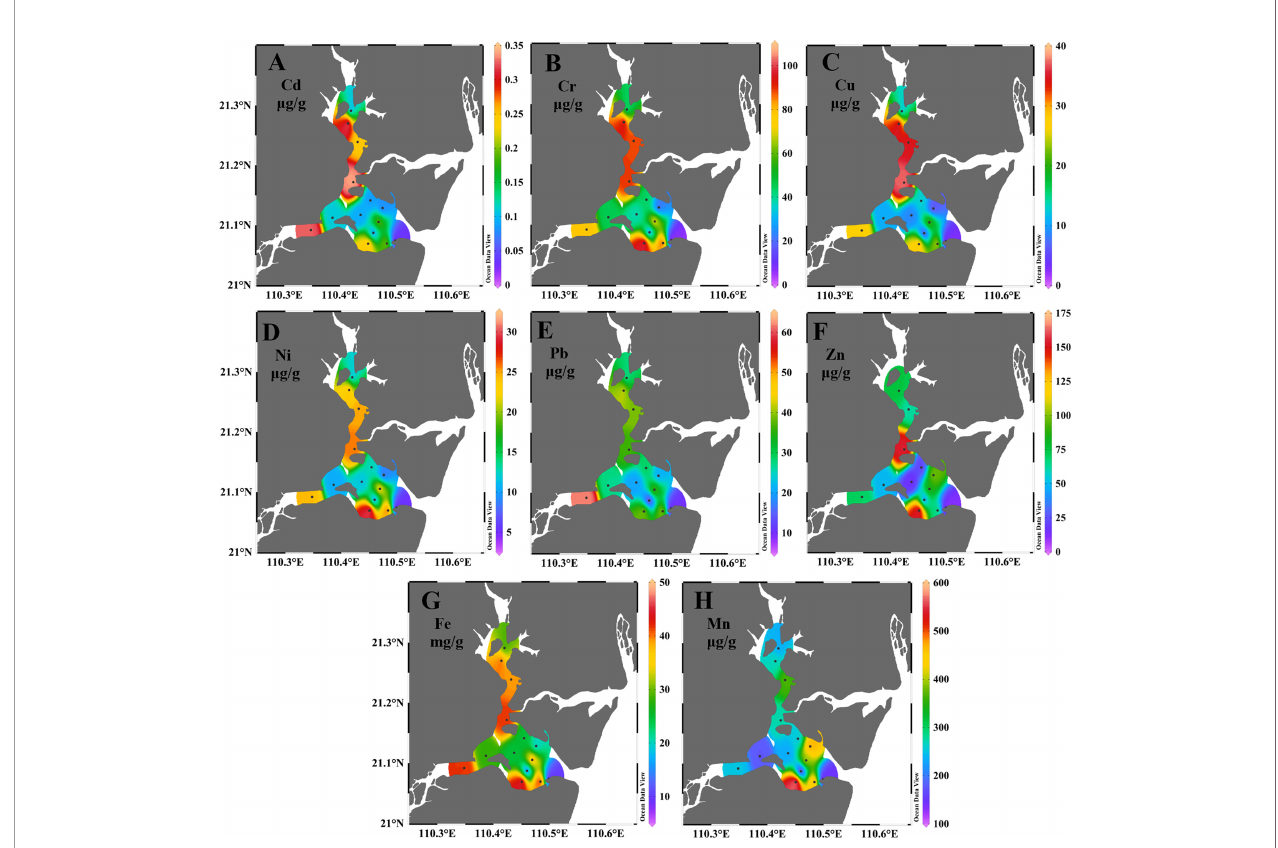
FIGURE 2 | The distribution of total metal concentrations for Cd (A) , Cr (B) , Cu (C) , Ni (D) , Pb (E) , Zn (F) , Fe (G) and Mn (H) in surface sediments of Zhanjiang bay in